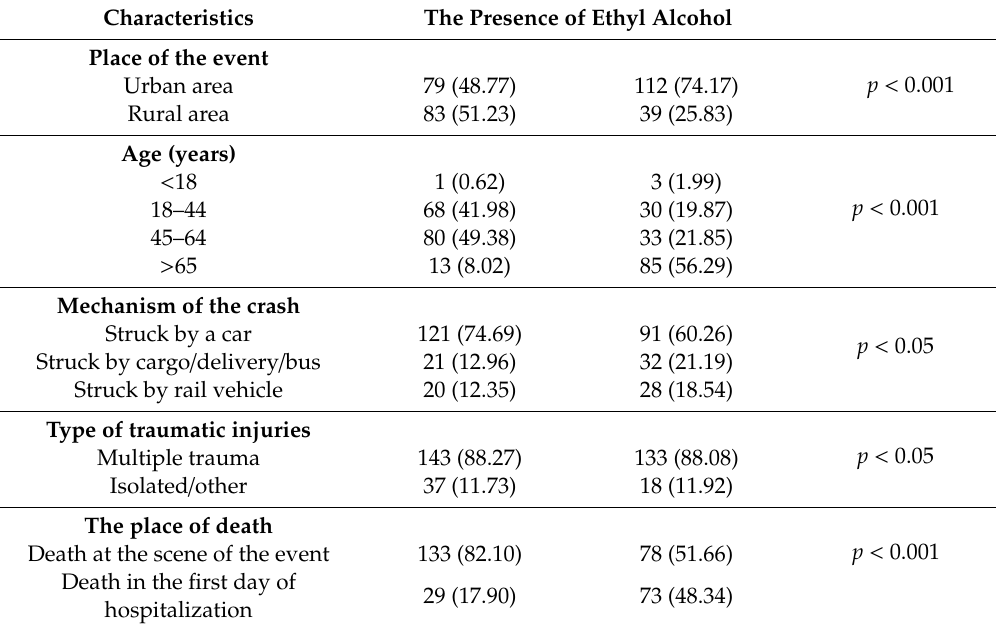
Table 3. Analysis of the relationship between alcohol levels and gender, place of event, and place of death.